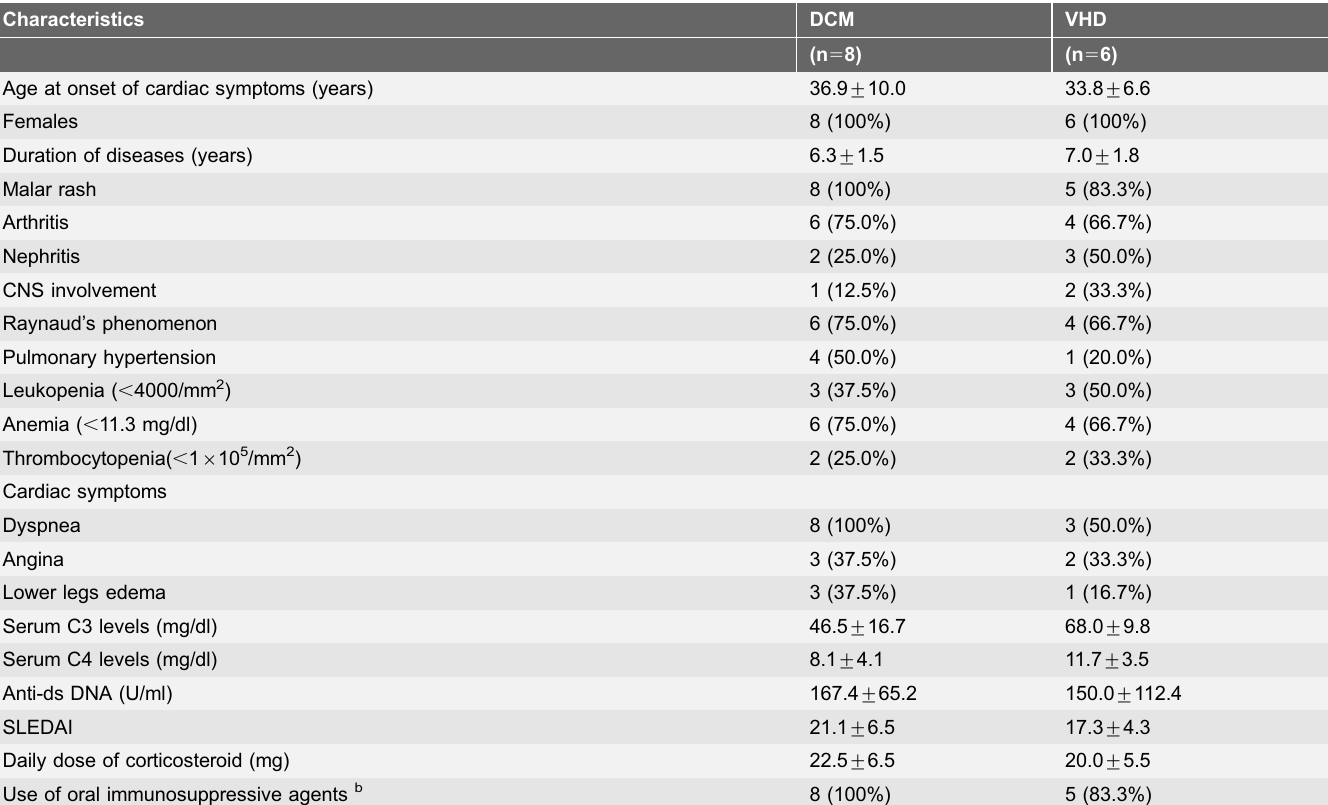
Table 1. Demographic data and clinical characteristics of SLE patients with dilated cardiomyopathies (DCM) and valvular heart diseases (VHD). a